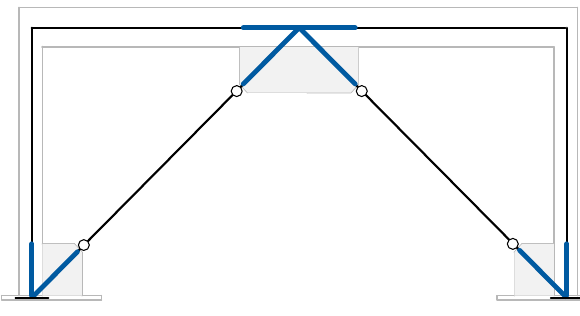
Figure 4. Buckling-restrained brace hysteresis curve.